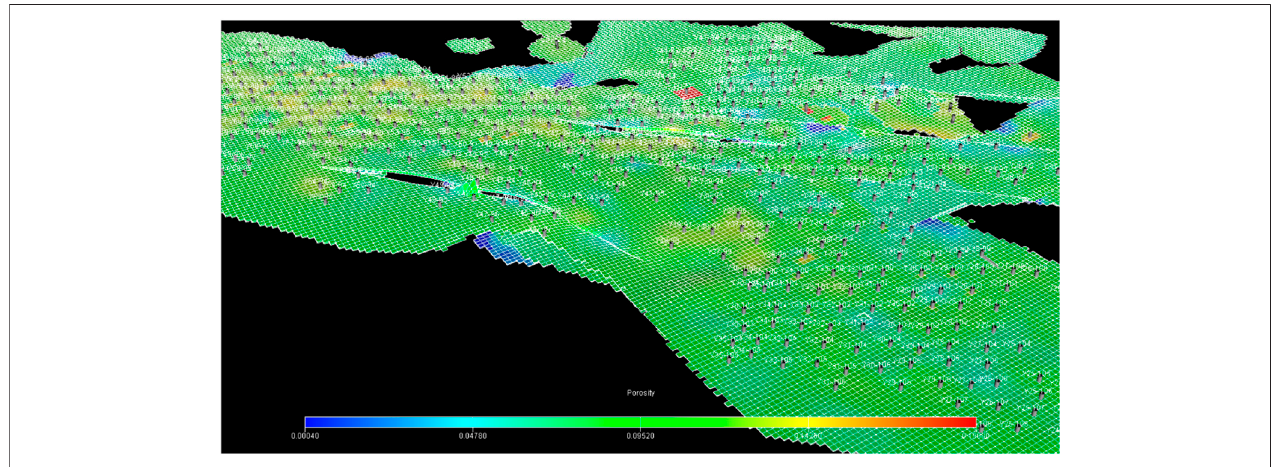
FIGURE 2 | Well location distribution map in the study area.